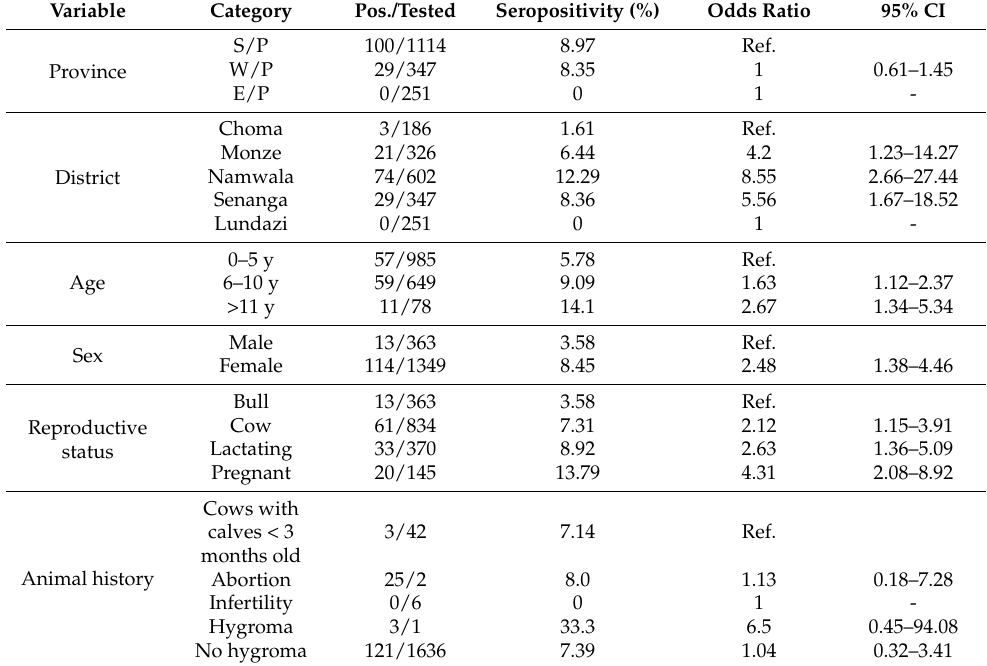
Table 4. Association between animal characteristics and individual animal-level brucellosis seroposi- tivity assessed by logistic